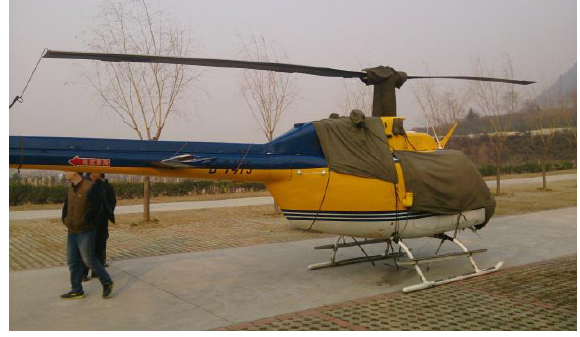
Figure 4. Bell 206 aircraft